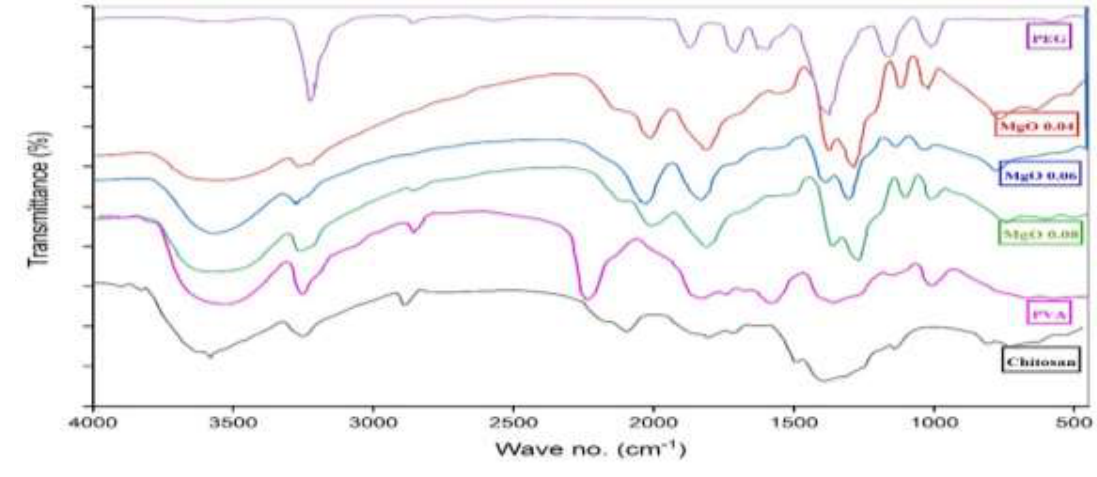
Figure 1: FTIR schemes for pure CHT, PVA, PEG, (0.04g, 0.06g, 0.08g) MgO nanocomposite